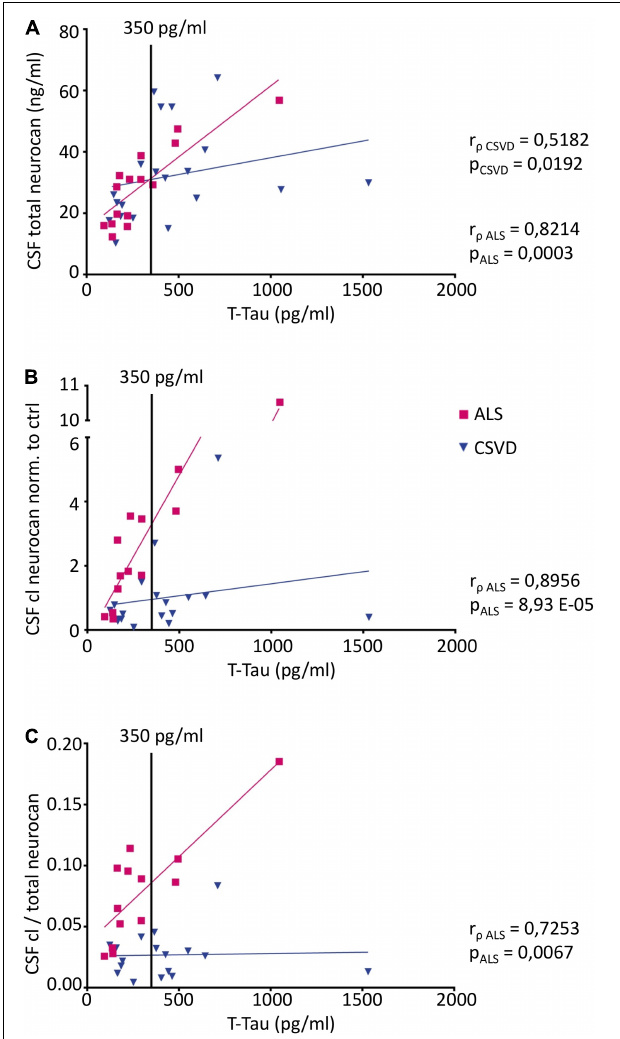
FIGURE 6 | Correlation analysis of CSF neurocan levels with the neurodegeneration marker total Tau (t-Tau) (Pairs CSF NCAN: ALS n = 15, CSVD n = 20; Pairs CSF cl. NCAN: ALS n = 13, CSVD n = 18; Pairs CSF cl./total NCAN: ALS n = 13, CSVD n = 18) (A) Total neurocan correlates with t-Tau levels both in the ALS and the CSVD group (ALS: r ρ = 0.8214, p = 0.0003; CSVD: r ρ = 0.5182, p = 0.0192). For cleaved neurocan (B) and for the ratio of cleaved to total neurocan (C) correlations with t-Tau were found in the ALS group only (CSF cl. NCAN: r ρ = 0.8956, p < 0.0001; CSF cl./total NCAN: r ρ = 0.7253, p = 0.0067). The t-Tau threshold value of 350 pg/ml is indicated with a black line.